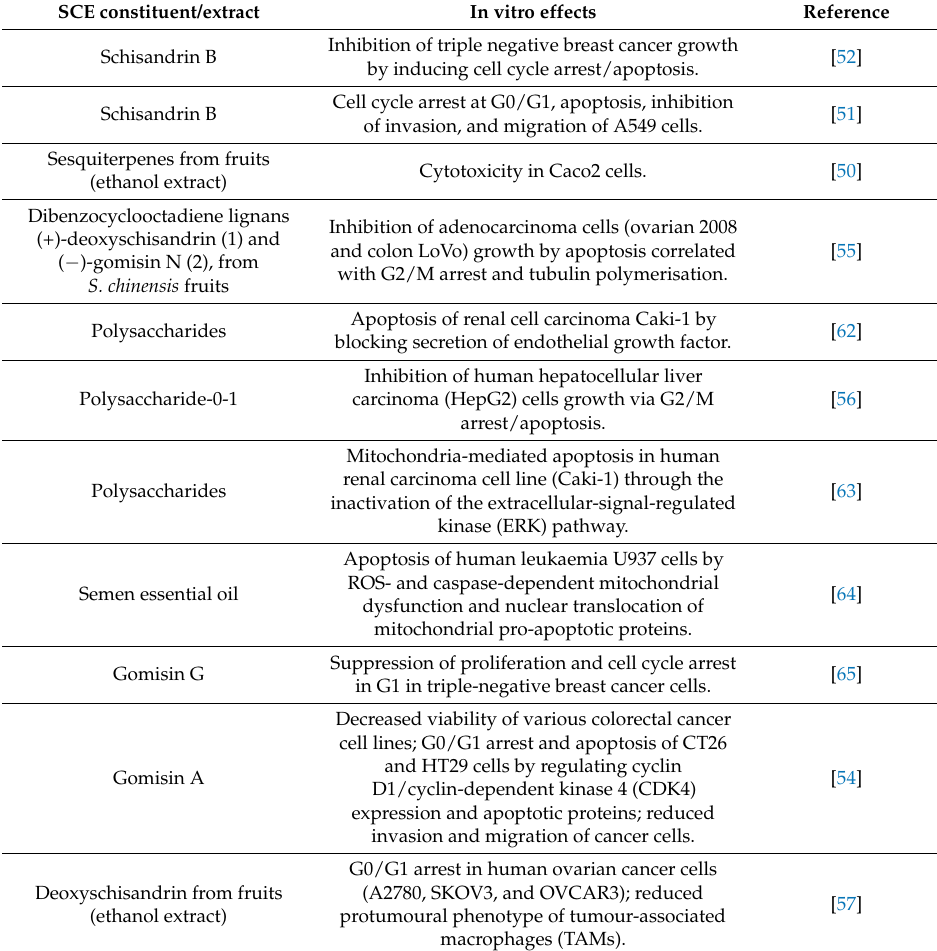
Table 1. Recent studies on the anti-cancer action of Schisandra chinensis (SCE) constituents. SCE constituent/extract In vitro effects